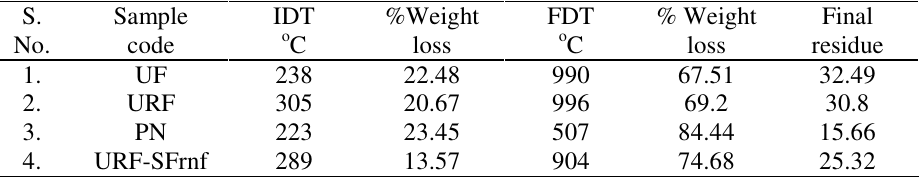
Table 4(b). Differential thermal analysis of UF, URF, PN an URF-SFrnf composites S.